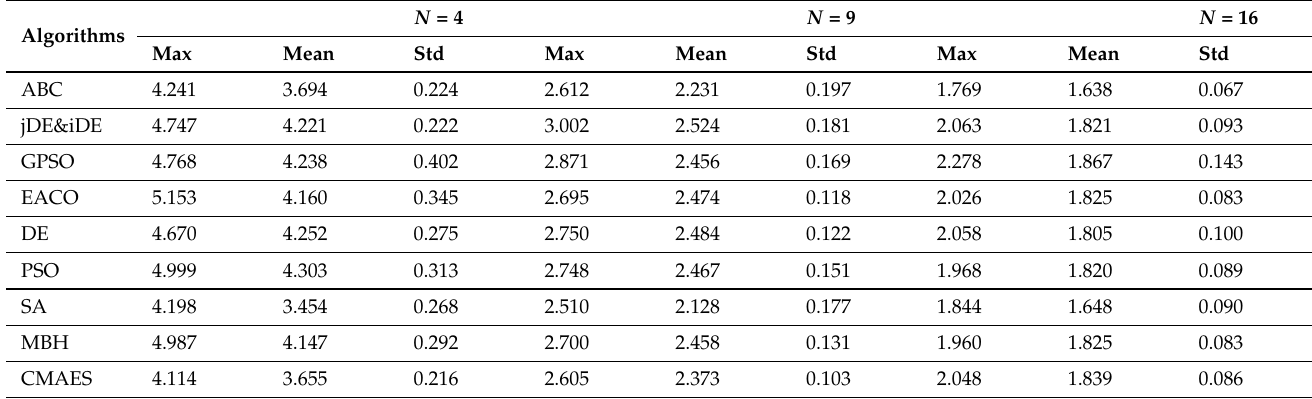
Table 2. Obtained solution (bps/Hz) of the numerical experiments.